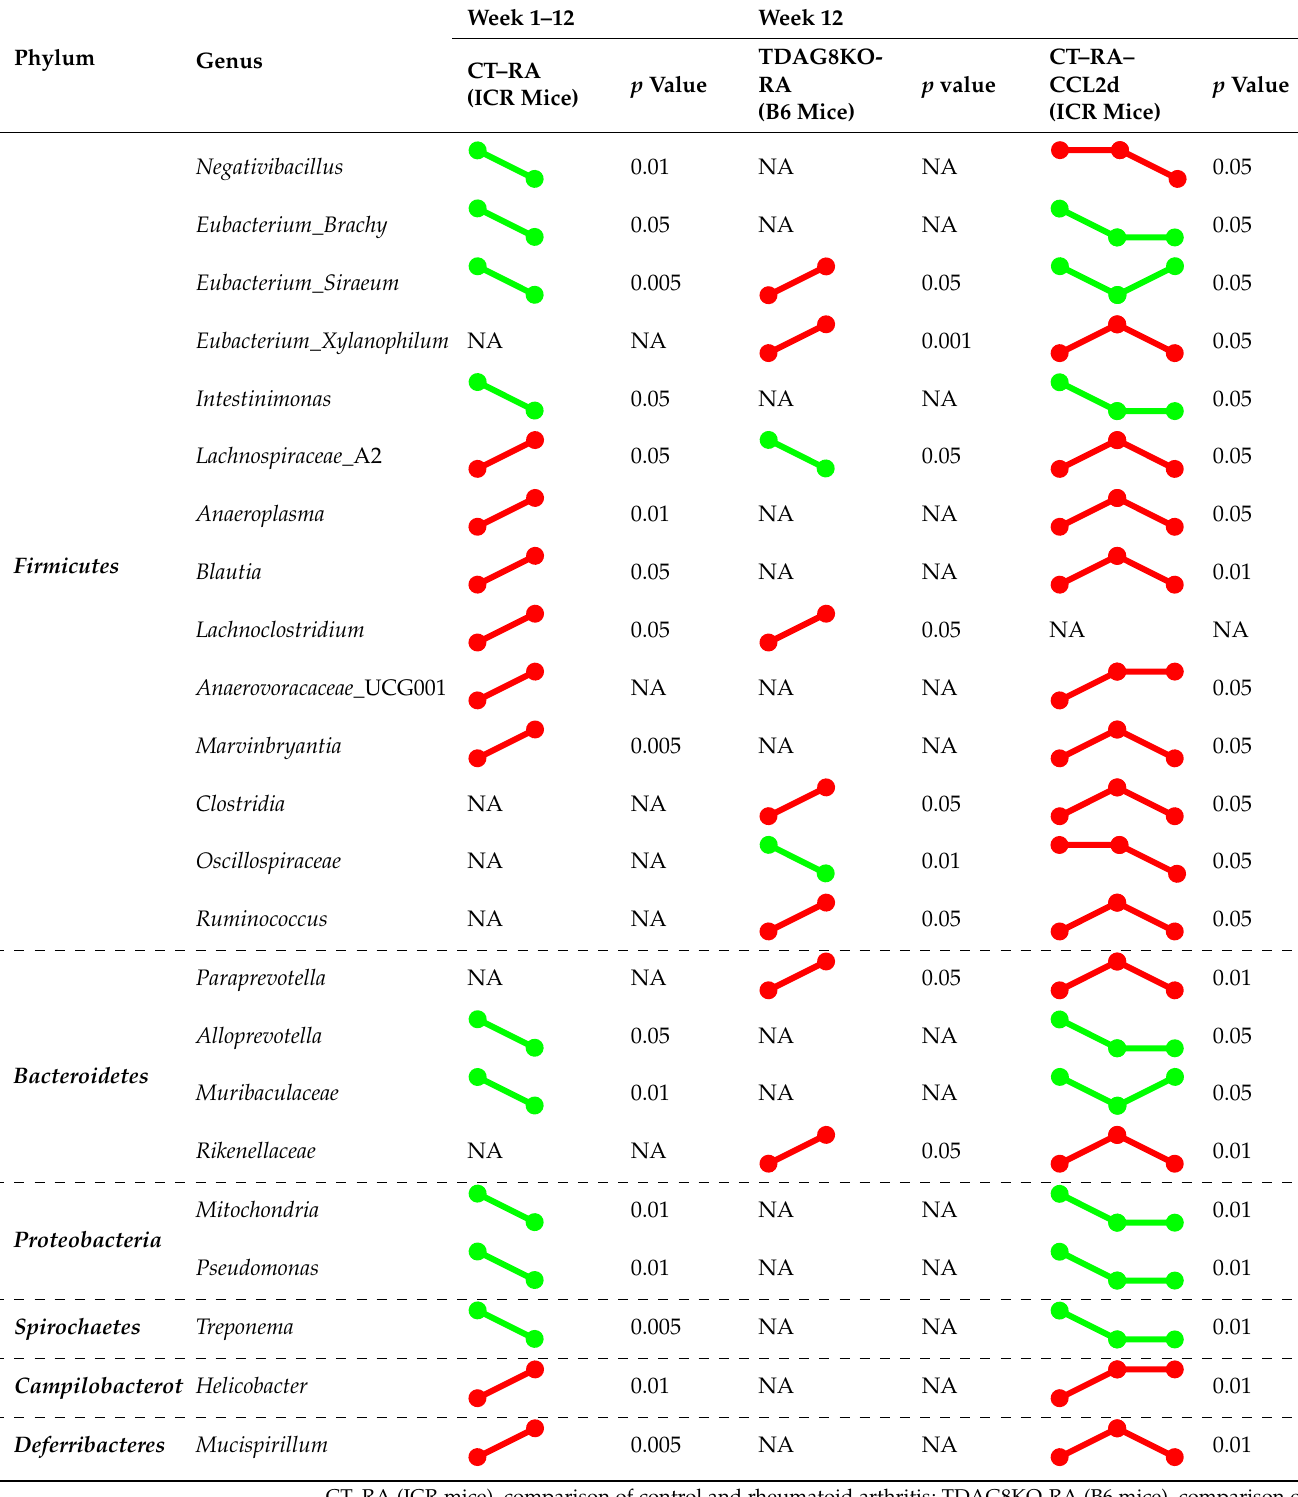
Figure 6. Composition of the cecal mucosa microbiome in healthy control, RA, TDAG8-deficient, and CCL-2d-treated mice at week 12. ( A ) Significantly abundant genera in RA and TDAG8-deficient B6 mice. ( B ) Significantly abundant genera in healthy control, RA, and CCL-2d treated ICR mice. Data are median (horizontal line), interquartile range (box edges) and range (whiskers). * p < 0.05; ** p < 0.01; *** p < 0.001, Wilcoxon rank-sum test.